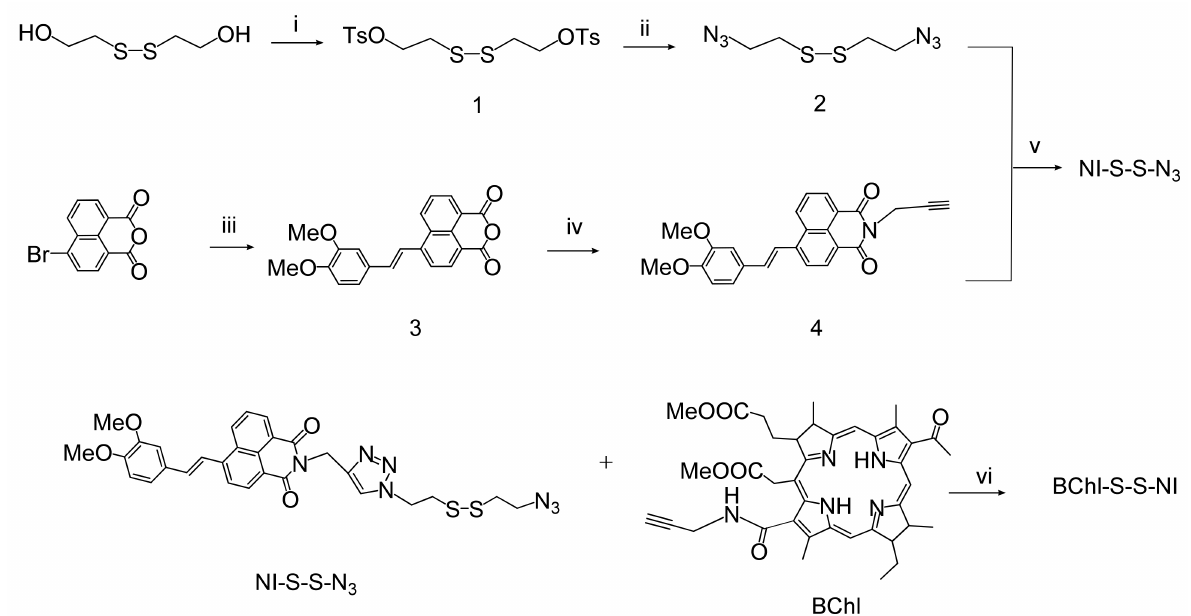
Figure 2. Synthetic route to BChl–S–S–NI. Reagents, conditions, and yields: (i) TsCl, NaOH, THF, 56%; (ii) NaN 3 , H 2 O/acetone, ∆ , 10%; (iii) 3,4-dimethoxystyrene, (o-tol) 3 P, Pd(OAc) 2 , DIPEA, CH 2 Cl 2 , ∆ , 50%; (iv) propargylamine, 2-methoxyethanol, ∆ , 85%; (v) CuI, DIPEA, CH DIPEA, CH 2 Cl 2 ,